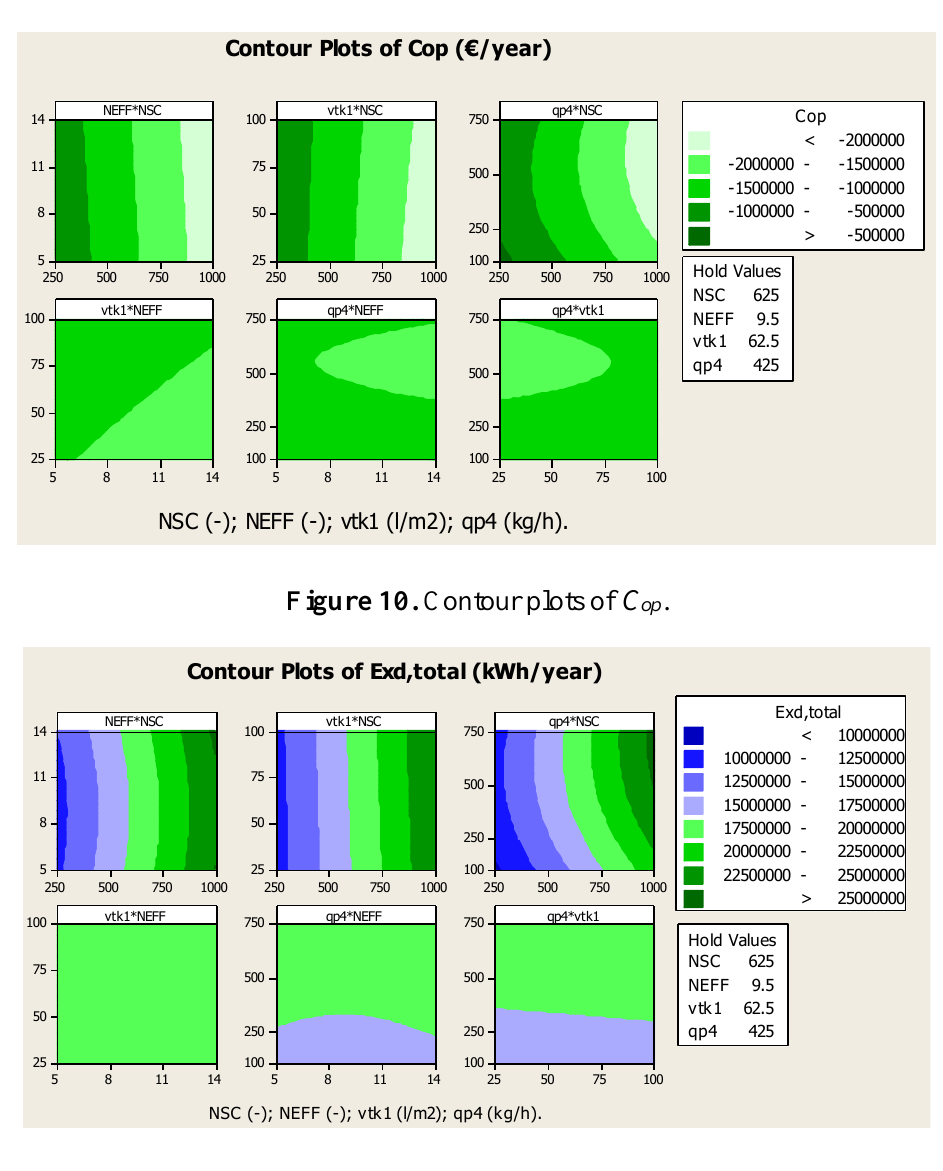
Figure 11. Contour plots of Ex d,total .